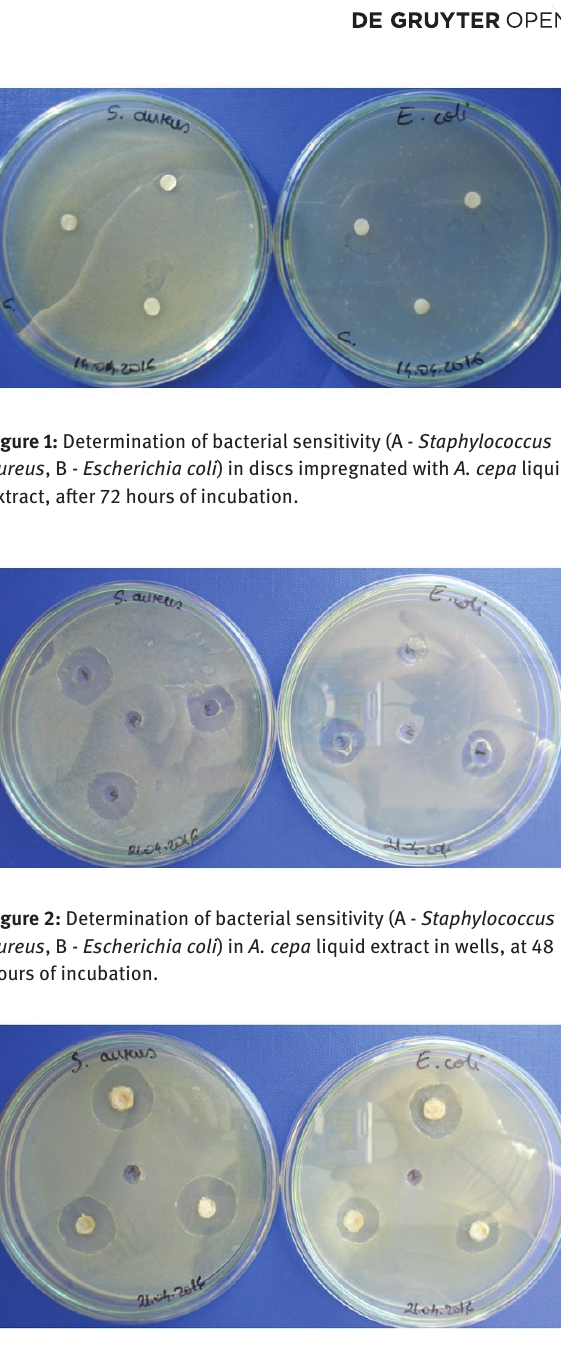
Figure 3: Determination of bacterial sensitivity (A - Staphylococcus aureus , B - Escherichia coli ) in the lyophilized formulation based on onion extract transformed by incorporation of ultrapure water, at 48 hours of